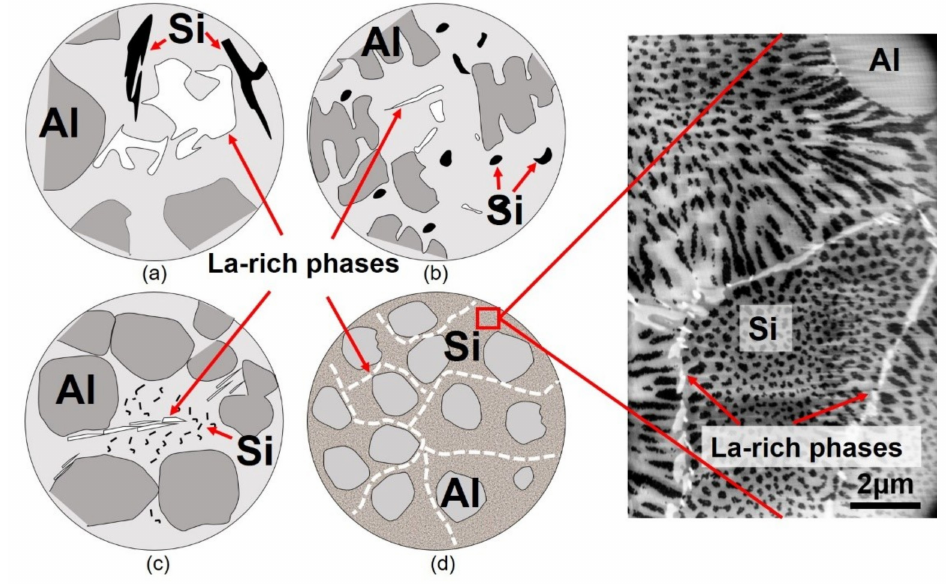
Figure 14. Schematics showing the microstructural evolution in La modified Al7SiMg alloys at the cooling rate of ( a ) 0.2 and ( b ) 9 K / s in the gravity die casting and ( c ) 30 and ( d ) 130 K / s in the semi-solid die